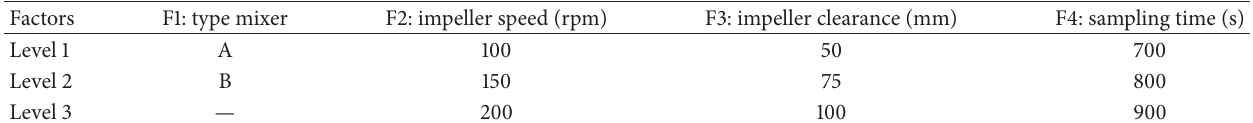
Table 1: The value of level of selected parameters in this study.